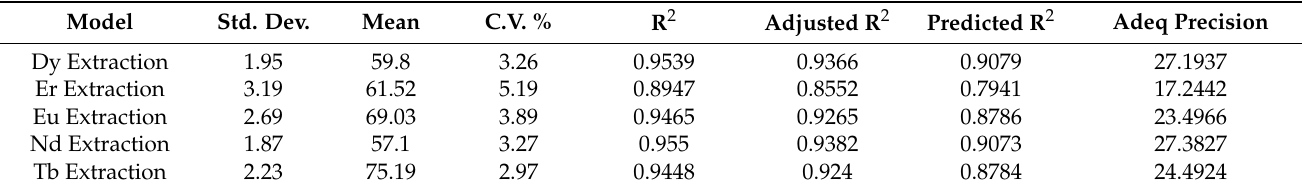
Table 12. Fit statistics for the Extraction Models of critical REEs.